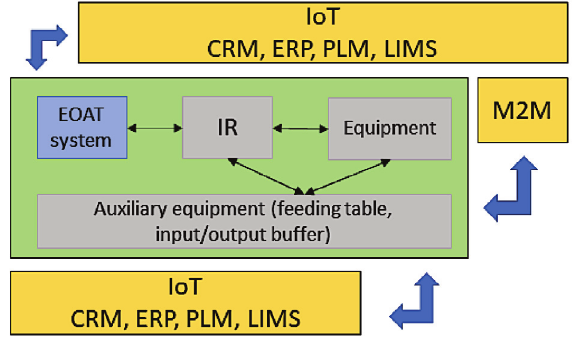
Fig. 2. Robot cell with CPS functionality. CRM – Customer Relations Management; ERP – Enterprise Resource Planning; PLM – Product Lifecycle Management; LIMS – Laboratory Information Management System; EOAT – End-of-Arm Tooling.